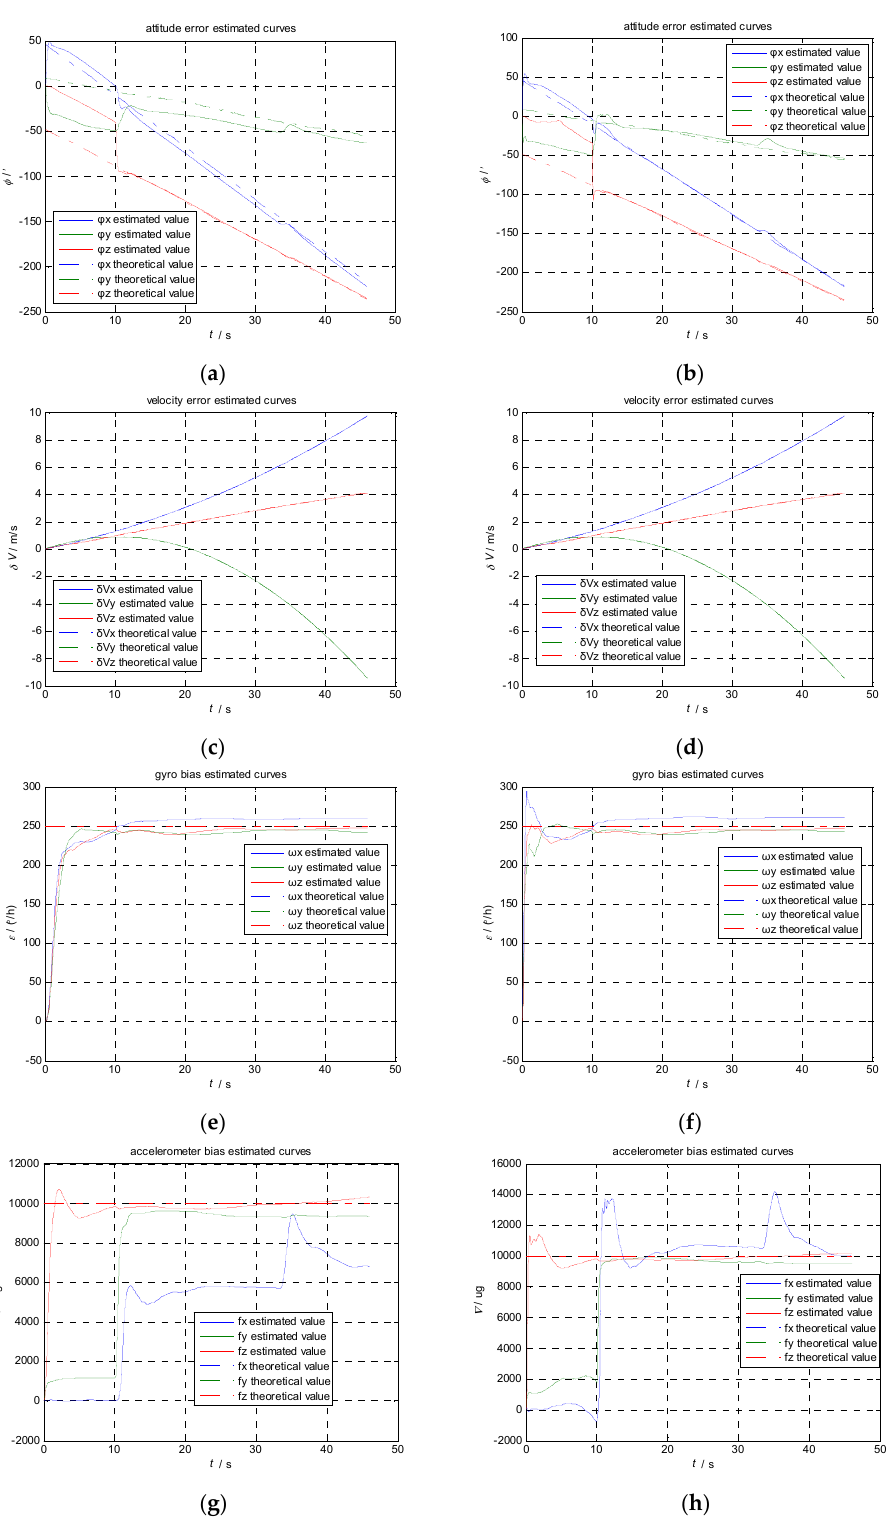
Figure 4. Comparison of estimation result using KF and AIKF. ( a ) Estimation of attitude error using KF; ( b ) Estimation of attitude error using AIKF; ( c ) Estimation of velocity error using KF; ( d ) Estimation of velocity error using AIKF; ( e ) Estimation of gyroscope bias using KF; ( f ) Estimation of gyroscope bias using AIKF; ( g ) Estimation of accelerometer bias using KF; ( h ) Estimation of accelerometer bias using AIKF.